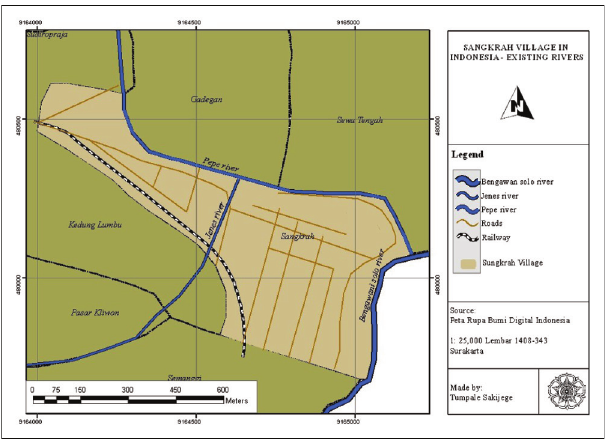
MSc thesis, The International Institute of Geo-Science and Earth Observation, Enschede FIGURE 1: Sangkrah informal settlement traversed by Bengawan Solo River, Central Java, Indonesia.